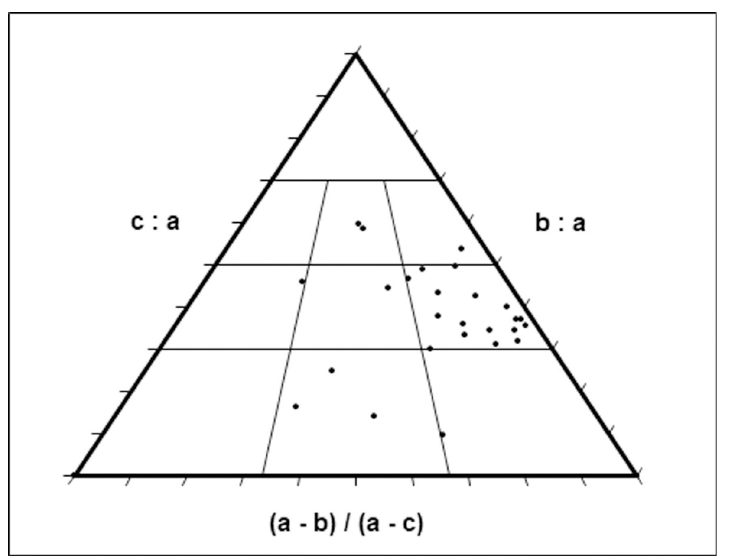
Fig 13. Comparative bone dimensions plot. Axes legends follow Sneed and Folk [103] where letters a, b and c represent the long, intermediate and short orthogonal axes of each bone fragment, respectively.